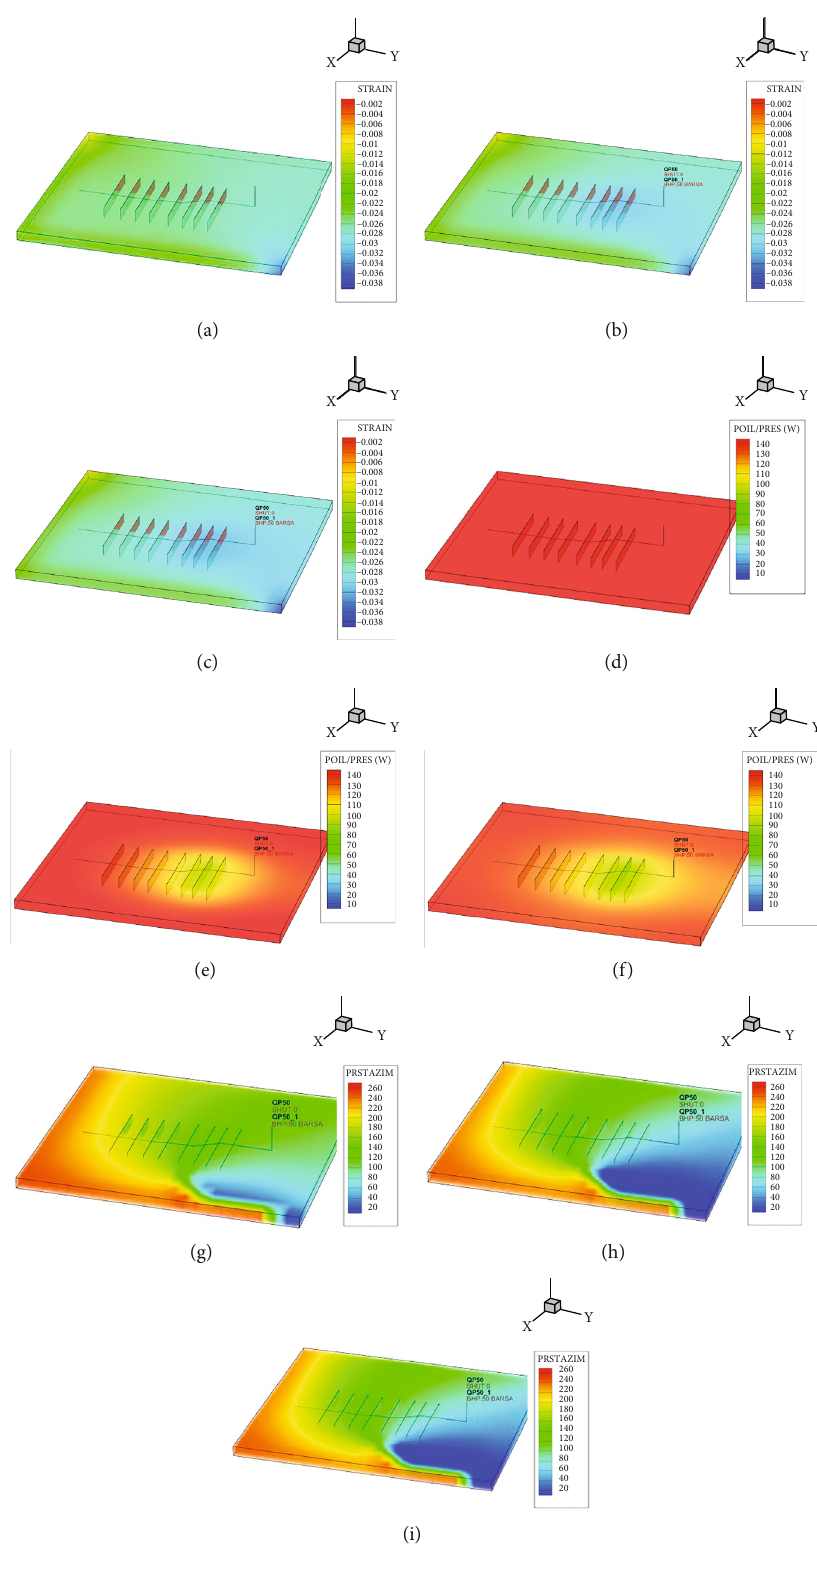
Figure 6: The simulation results of Case